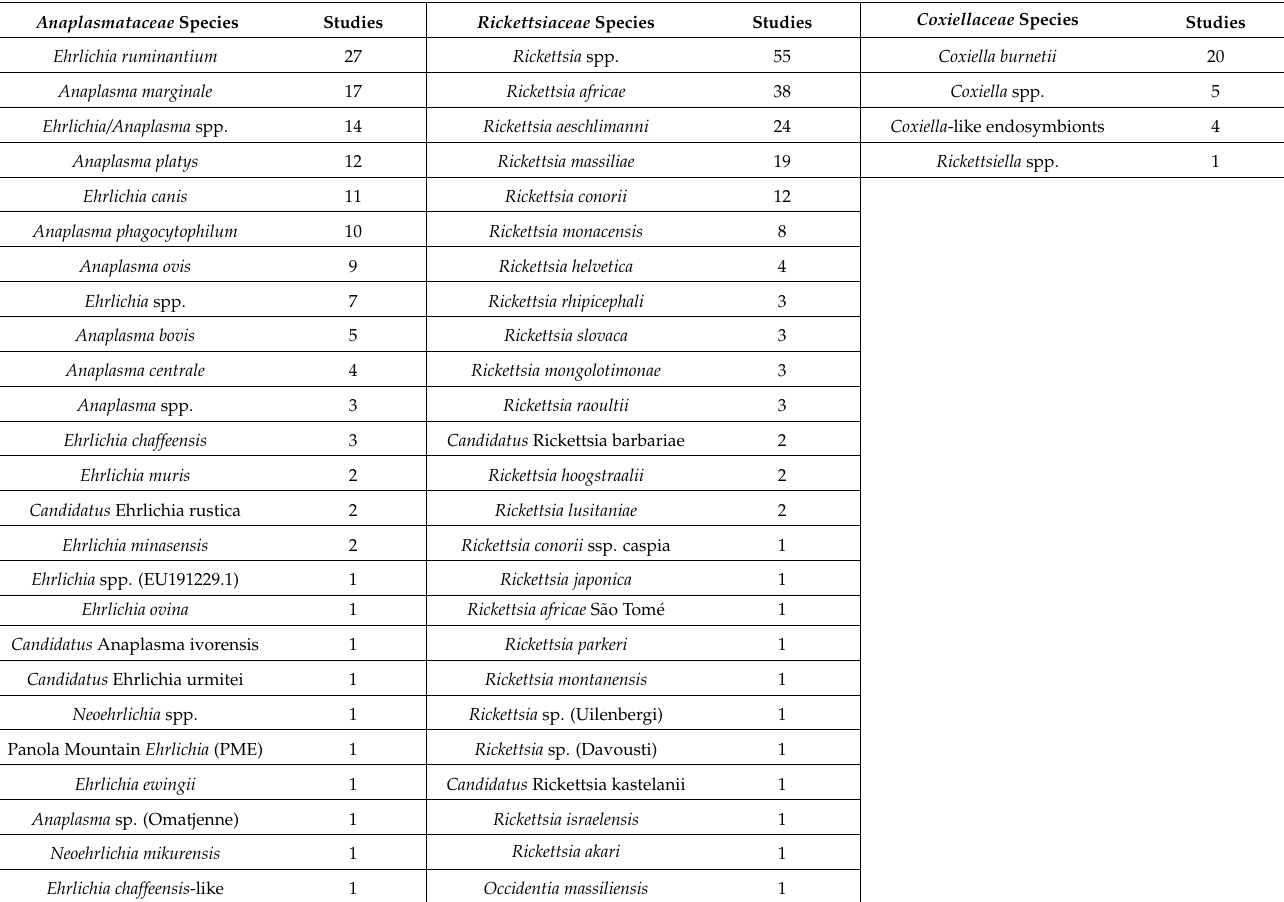
Table 1. Frequency distribution of Anaplasmataceae , Rickettsiaceae and Coxiellaceae pathogens detected in African ticks.